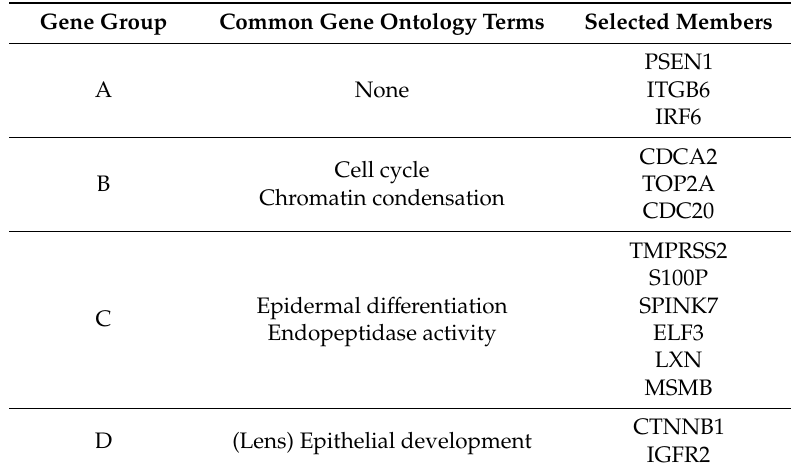
Table 1. Co-regulated gene clusters during prostate epithelial cell di ff erentiation.